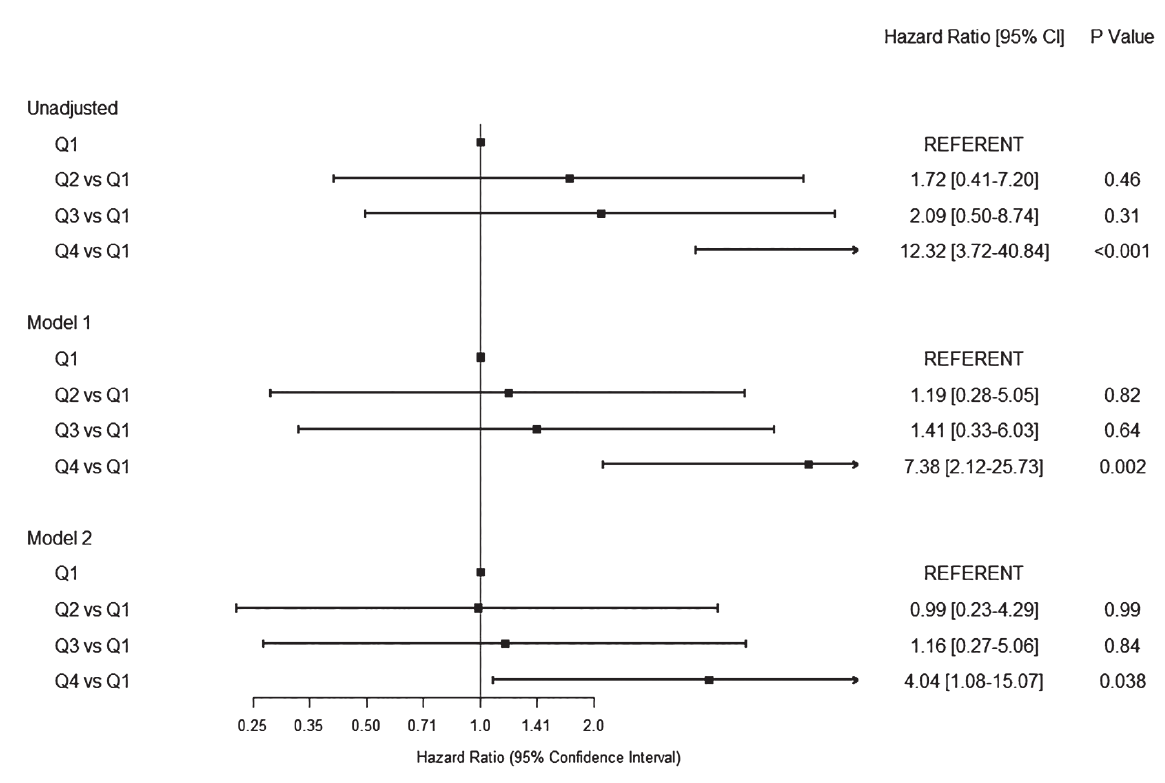
Figure 2. Forest Plot Depicting the Association Between Quartiles of Acute RDW and Mortality in Three Models Unadjusted; Model 1 (adjusted for age, sex, race); Model 2 (adjusted for age, sex, race, cardiovascular disease, and